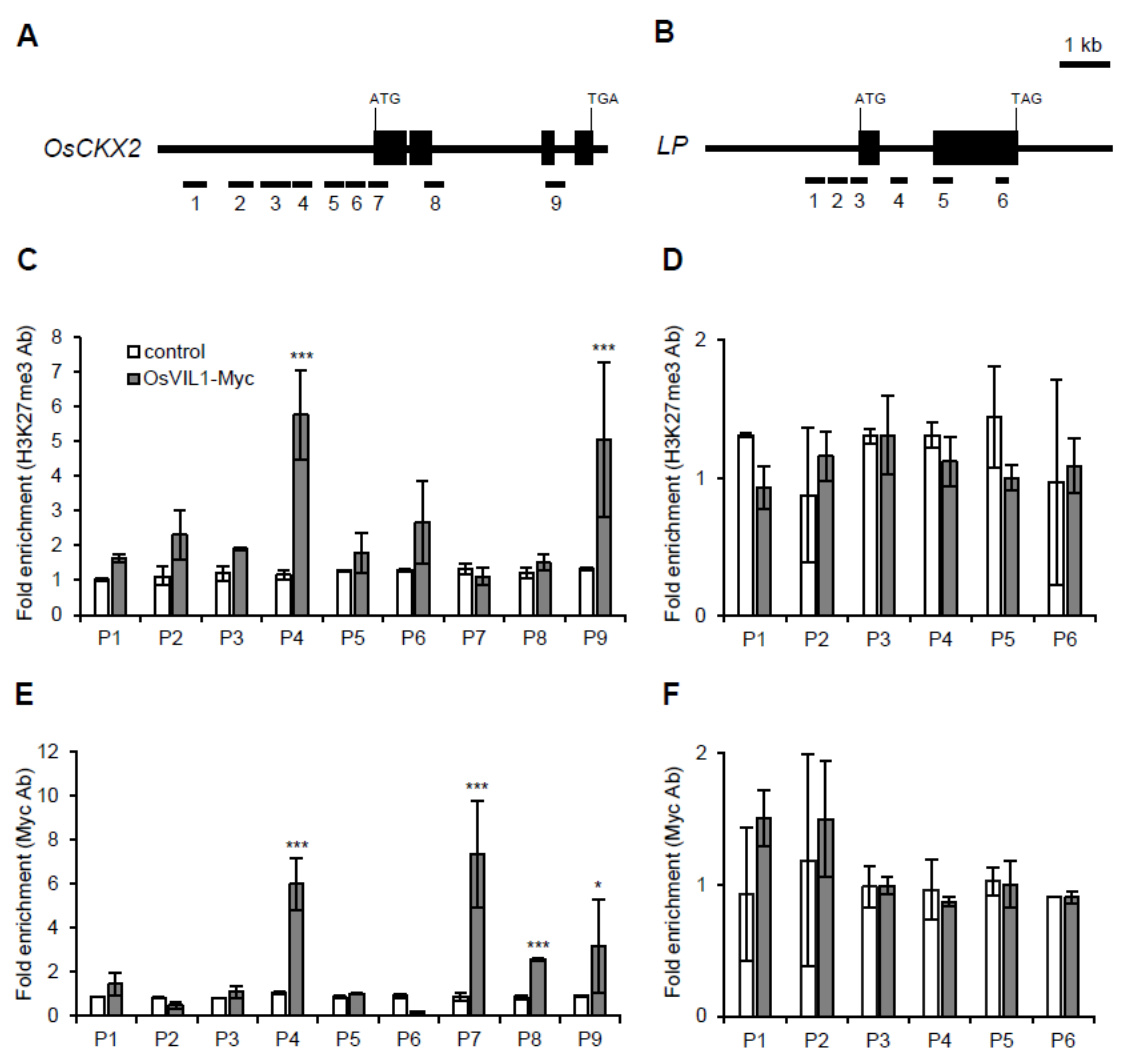
Figure 7. Chromatin immunoprecipitation assay of OsVIL1 in OsCKX2 chromatin. Samples were prepared from the upper 0.5 cm of the cell division region in the second internode before the heading stage, n = 10. ( A , B ) Genomic structure of OsCKX2 and OsLP . OsVIL1-Myc transgenic plants were used for the chromatin immunoprecipitation assay. As a control, we used Myc-empty transgenic plants. ( C , D ) Analysis of H3K27me3 chromatin states in OsCKX2 chromatin ( C ) and OsLP ( D ). ( E , F ) Enrichment of OsCKX2 ( E ) and OsLP ( F ) chromatin in OsVIL1-Myc transgenic plants. The entire experiment was conducted three times and the graph shown are from one of the three experiments. The error bars indicate the standard deviations. Statistical significance is indicated by *** ( p < 0.001), * ( p < 0.01).